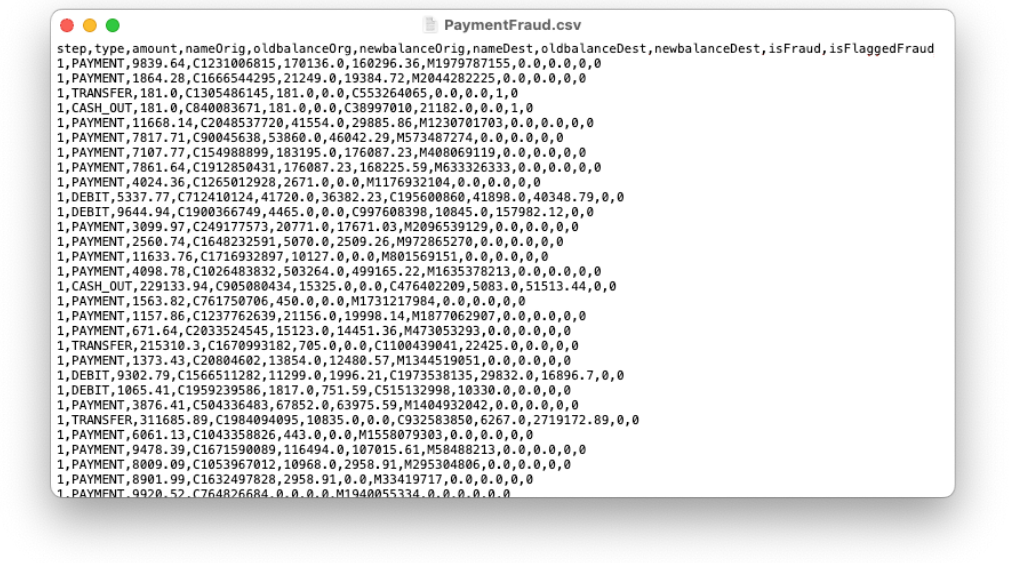
Figure 9. An example view of the ‘PaymentFraud.csv’